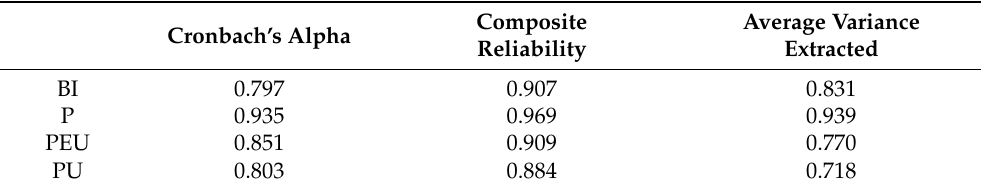
Table 4. Validity and reliability.